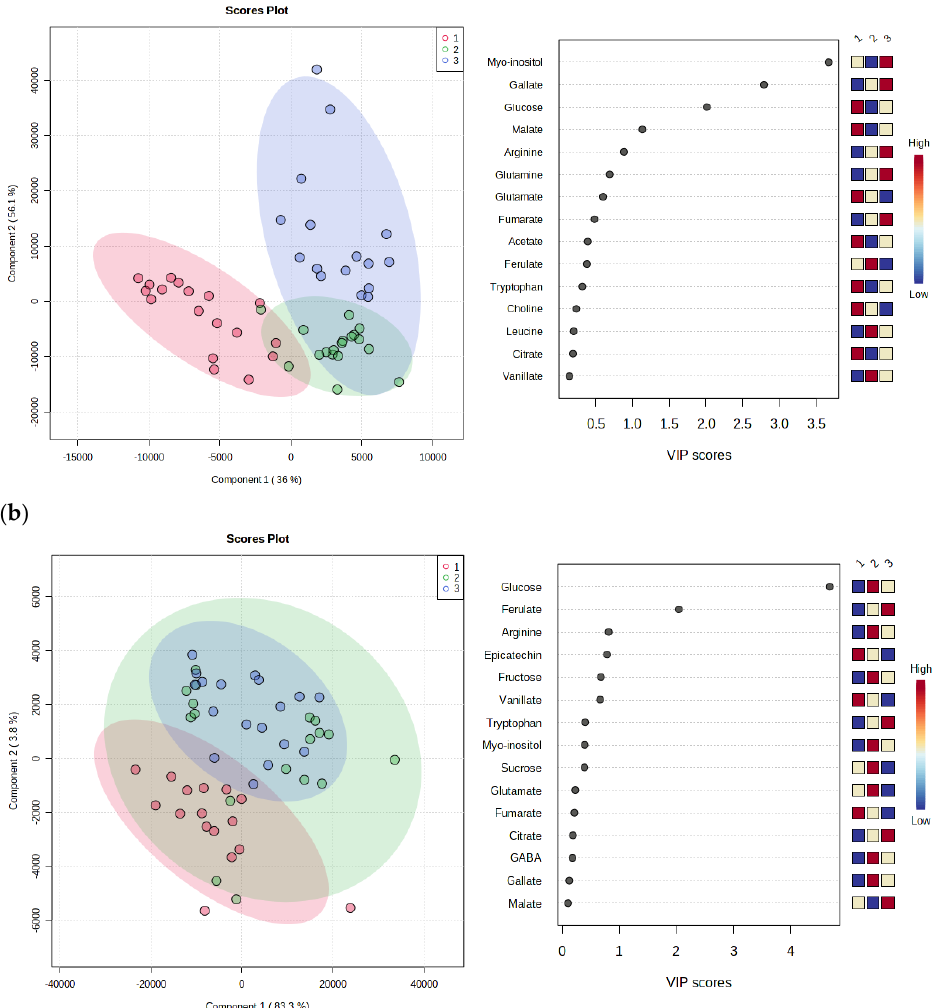
Figure 6. PLS-DA plot for pomegranate tree leaves cultivated in tree substrates and VIP scores with the corresponding heat map where red and blue indicates the level of metabolites. The results were analysed according to ( a ) the phenological stage where 1 represent flowering stage (FP); 2 fruit development (DF); and 3 post-harvest (PostR); and ( b ) the substrate used to pomegranate cultivation where 1 is 100% peat (PS0); 2 peat and sediment mixed (PS50); and 3 100% sediment.